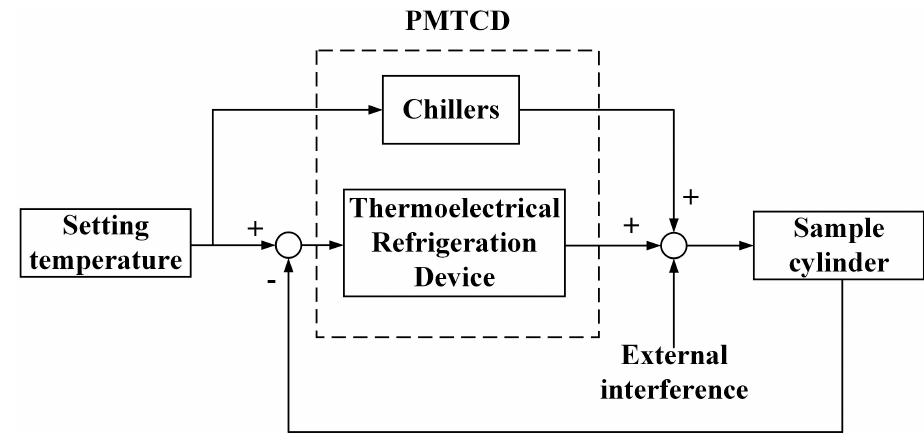
Figure 3. The PID control schematic for PMTCD.